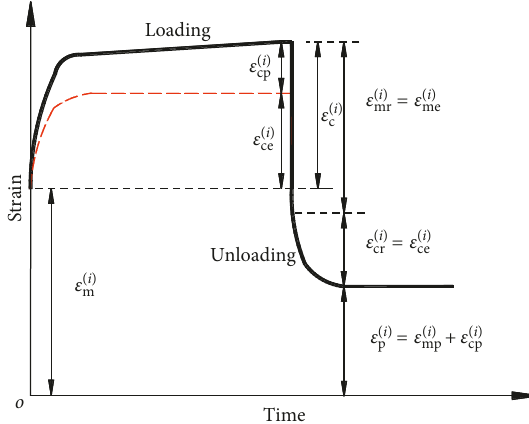
Figure 4: Representative rheological curve under loading and unloading.